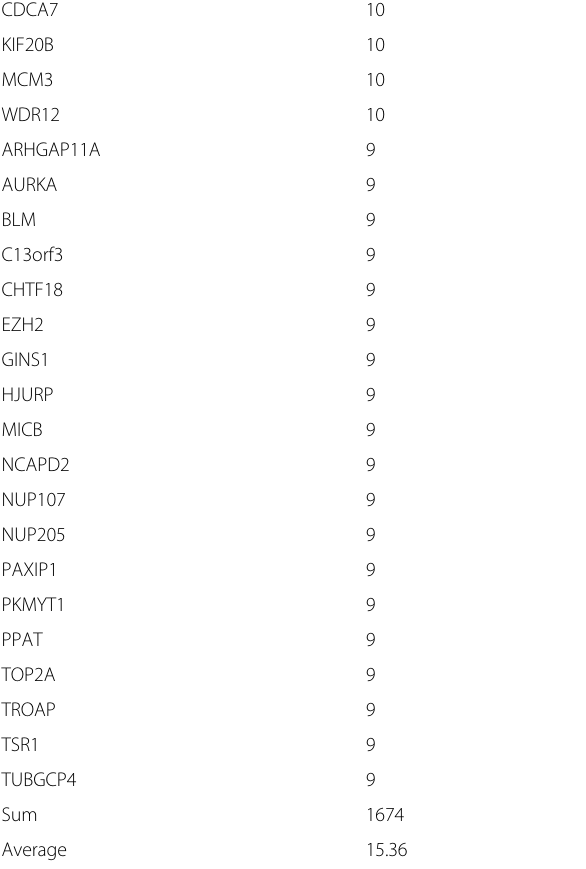
Table 2 Top-ranking genes that co-express with 64 core centromere-kinetochore components